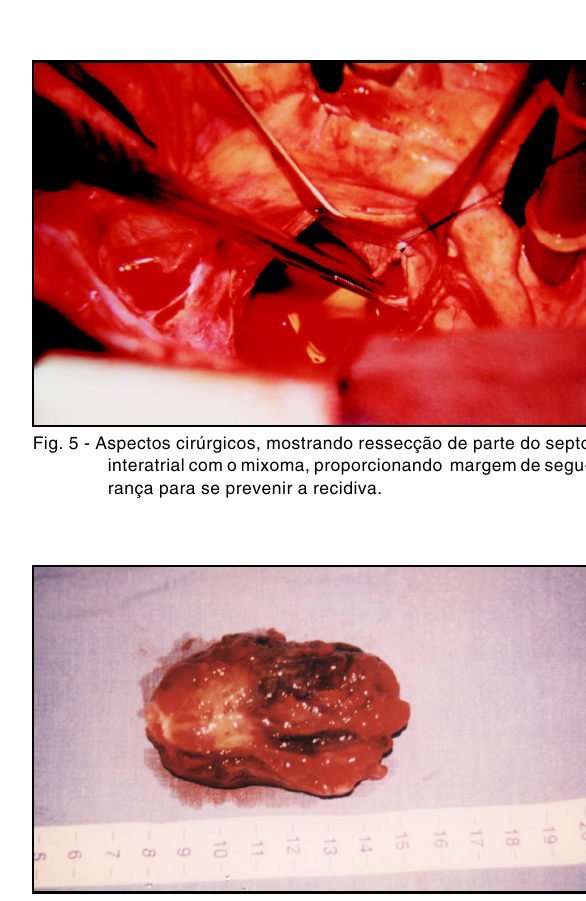
Fig. 6 - Aspectos macroscópicos da peça cirúrgica, medindo 73 mm em seu maior diâmetro, de coloração amarelada, com áreas hemorrágicas e aparência típica de